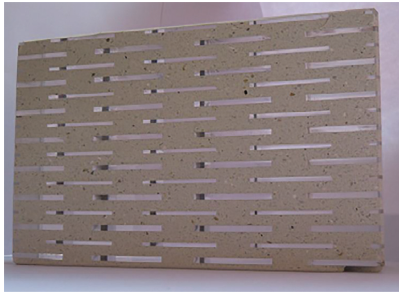
Figure 2: Resin transparent concrete.